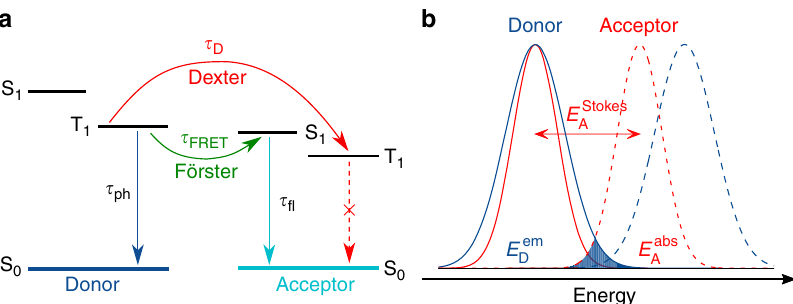
Fig. 1 Working principle of unicolored phosphor-sensitized fl uorescence. a Radiative decay paths of phosphor-sensitized fl uorescence. Long-range Förster resonance energy transfer from the triplet state of the phosphorescent donor to the energy-matched singlet state of a fl uorescent acceptor reduces excited state decay time while preserving the emission color. Unwanted Dexter transfer to the acceptor triplet state can lead to a reduced quantum ef fi ciency. b Spectral properties: absorption (dashed lines) and emission (solid lines) of donor (blue) and acceptor (red) in a unicolored phosphor-sensitized fl uorescence system. The shaded area indicates the spectral overlap J of donor emission and acceptor